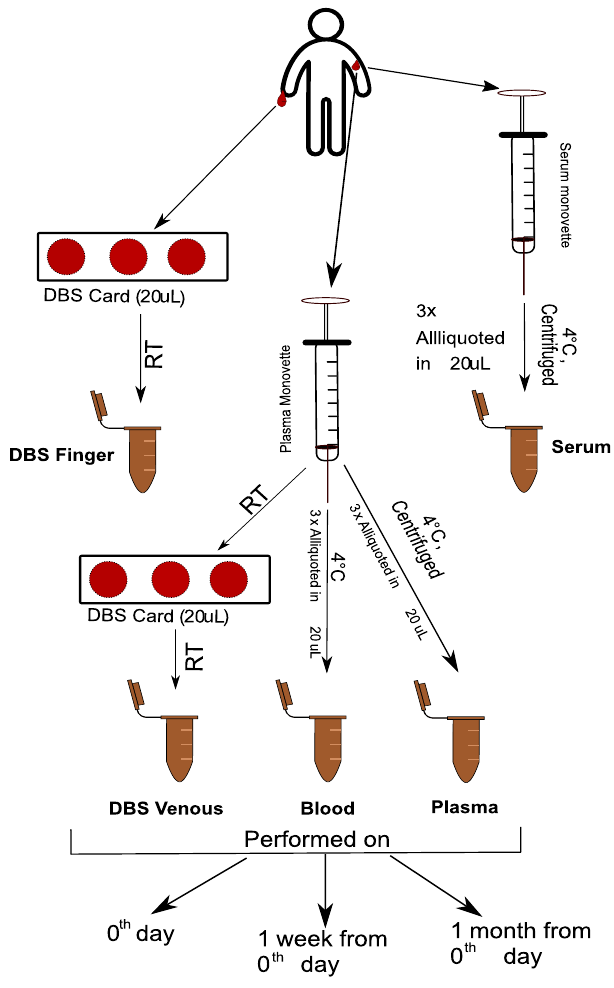
Fig. 8 | Work fl ow of sample collection for the LBlooD study. Schematic repre- sentationofthesamplingandpre-processingstrategyforlipidextractionfrom fi ve different biological matrices in an individual. The same extraction procedure was followed for sample preparation on the 0th day, 1 week from the 0th day, and 1 month from the 0th day. This procedure was followed for the sample collection from all participating individuals in the